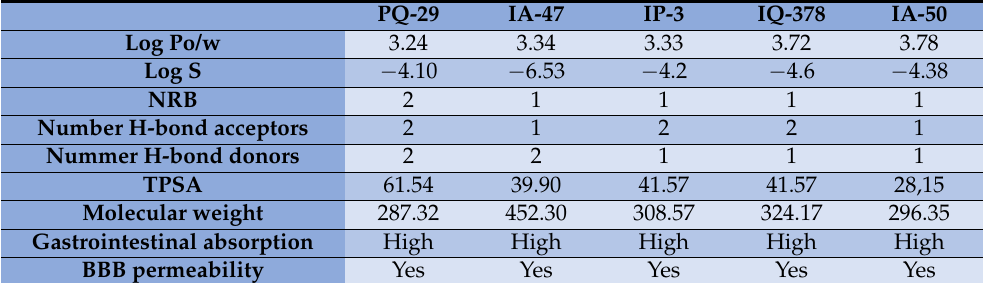
Table 1. Computationally predicted absorption, distribution, metabolism and excretion (ADME), and other drug-likeness profiles of pyrrolyl- and indolylazine.